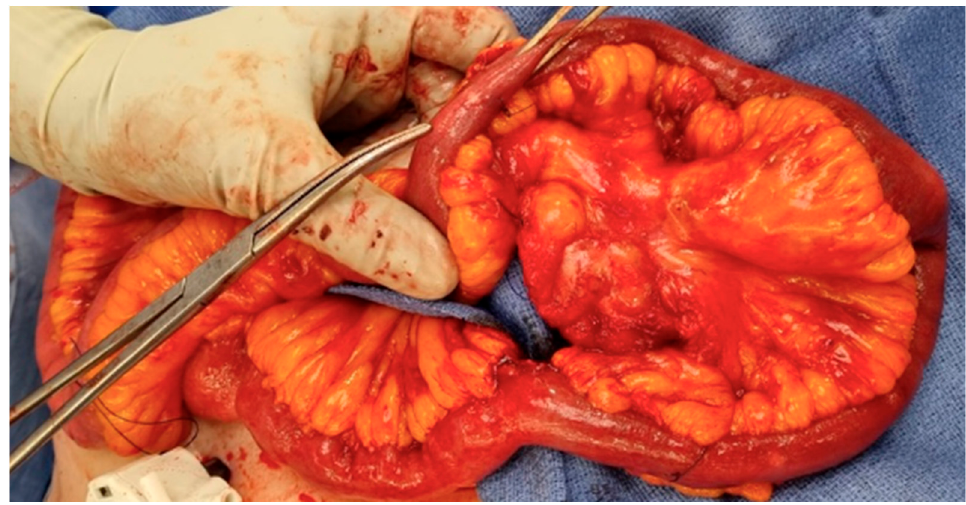
Figure 3. Clinical photograph of a section of the small bowel with the mesentery resected, and Rob- erts forceps indicating the small bowel nodule. Roberts forceps indicating the small bowel